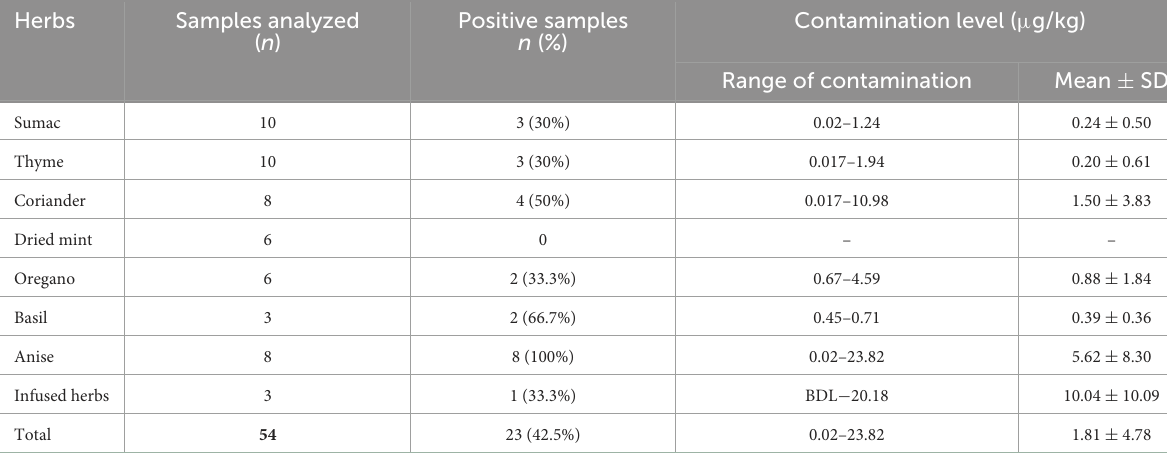
TABLE 4 Incidence and occurrence of OTA in different kinds of herbs in Lebanon. Herbs